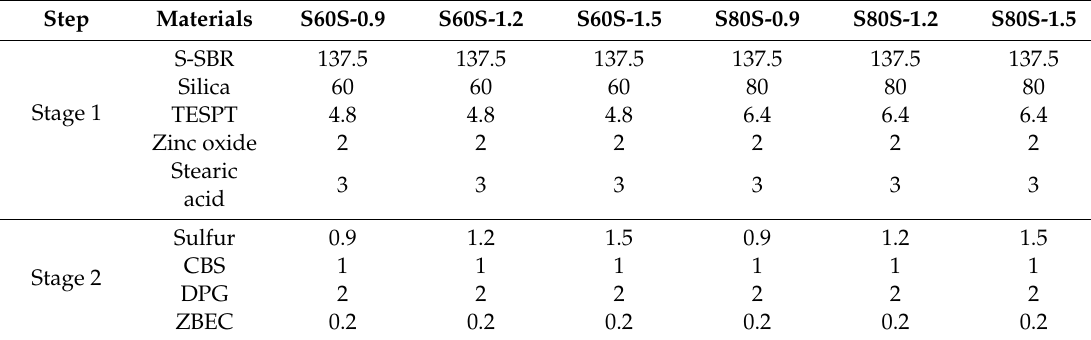
Table 1. Formulation of compounds (unit: phr).